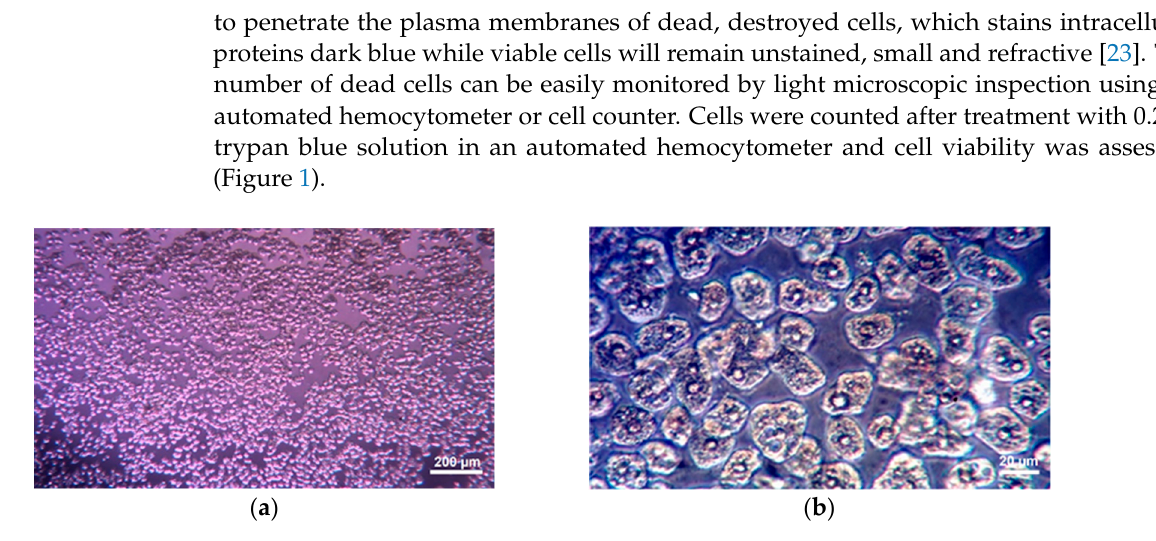
Figure 1. Liver cells visualized with the inverted microscope with KZD phase contrast. ( a )—10 × , ( b )—40 ×